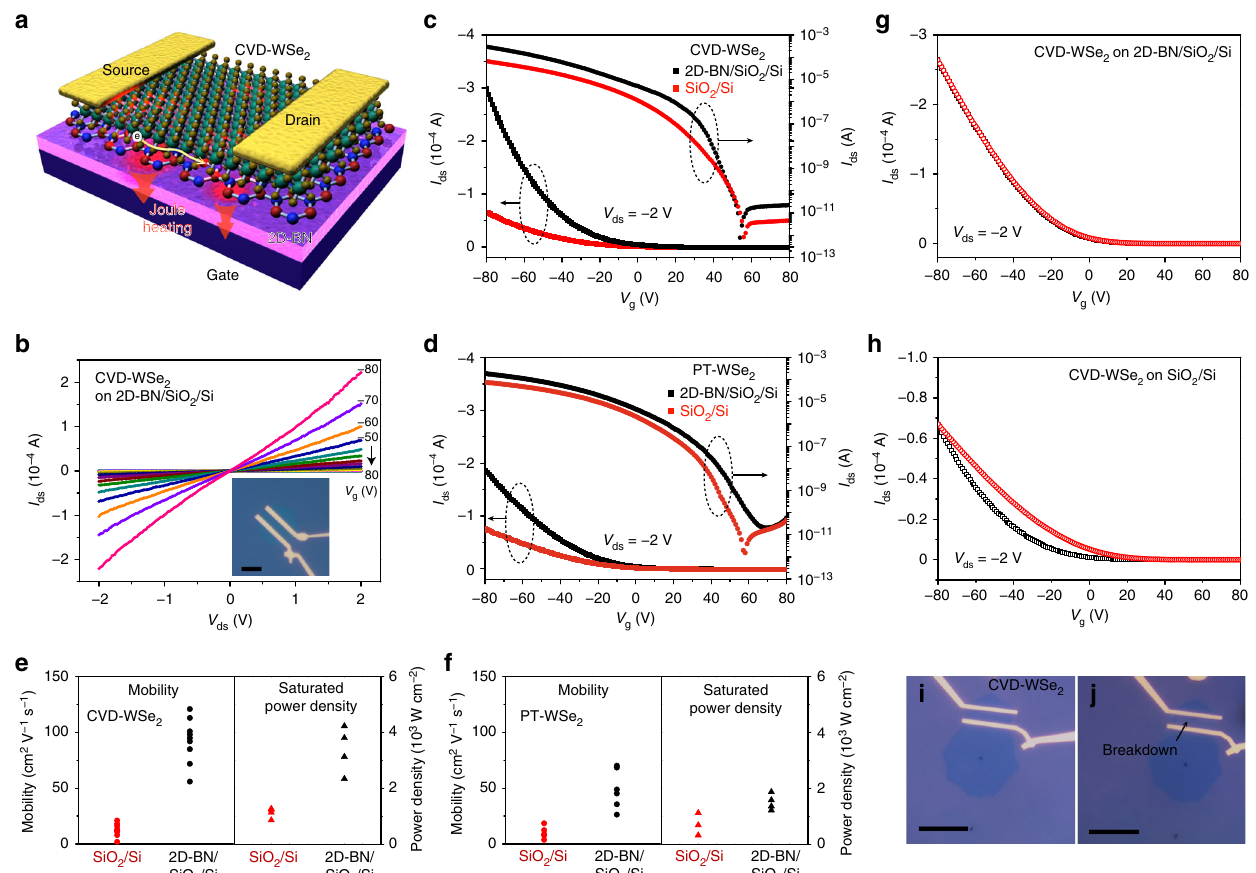
Fig. 5 Two-dimensional hexagonal-boron nitride (2D-BN) as dielectric interfacial material in fi eld-effect transistors (FETs). a Schematic illustration of a CVD-WSe 2 FET device using 2D-BN as the dielectric interface. b Output curves of the CVD-WSe 2 FET on 2D-BN/SiO 2 /Si. The inset shows the optical image of the device. c , d Transfer curves ( V ds = − 2 V) of the CVD-WSe 2 FET and a PT-WSe 2 FET on 2D-BN/SiO 2 /Si and on bare SiO 2 /Si. e , f Mobility and saturated power density of the CVD-WSe 2 FET and the PT-WSe 2 FET on 2D-BN/SiO 2 /Si and on bare SiO 2 /Si. g , h Transfer curve ( V ds = − 2 V) of a CVD- WSe 2 FET on 2D-BN/SiO 2 /Si and on SiO2/Si. The black and red curves are obtained when V g sweeps from 80 to − 80 V and from − 80 to 80 V, respectively. i , j Optical images of a CVD-WSe 2 FET on 2D-BN/SiO 2 /Si before and after current breakdown. Scale bars in b , i , j are 20 μ (Fig. 5e, f), calculated by the power at the current breakdown divided by the device area, reaches up to 4.23 × 10 3 (CVD-WSe 2 ) and 1.87 × 10 3 W cm − 2 (PT-WSe 2 ) on 2D-BN/SiO 2 /Si, higher than that on bare SiO 2 /Si, indicating that the ne-PECVD 2D-BN not only increases the device mobility but also increases device